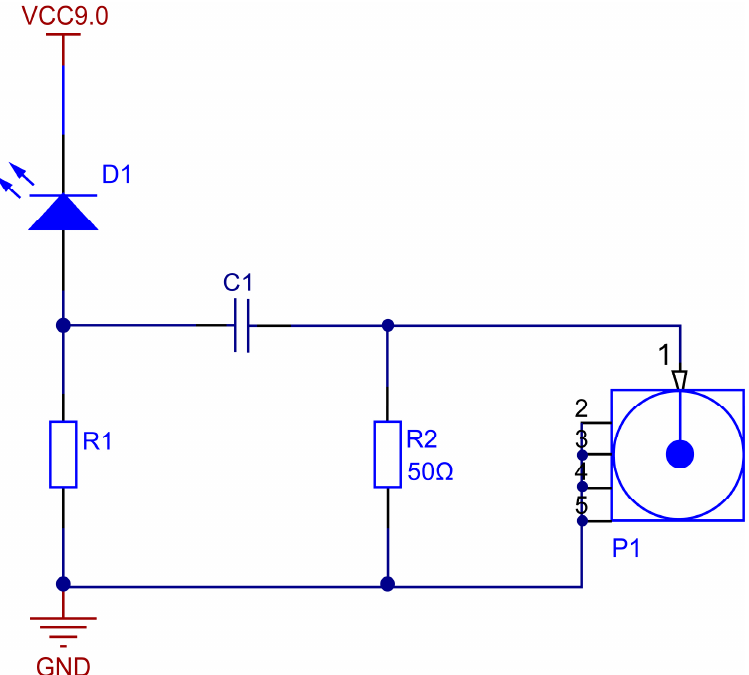
Figure 13. Photodetector connection circuit.